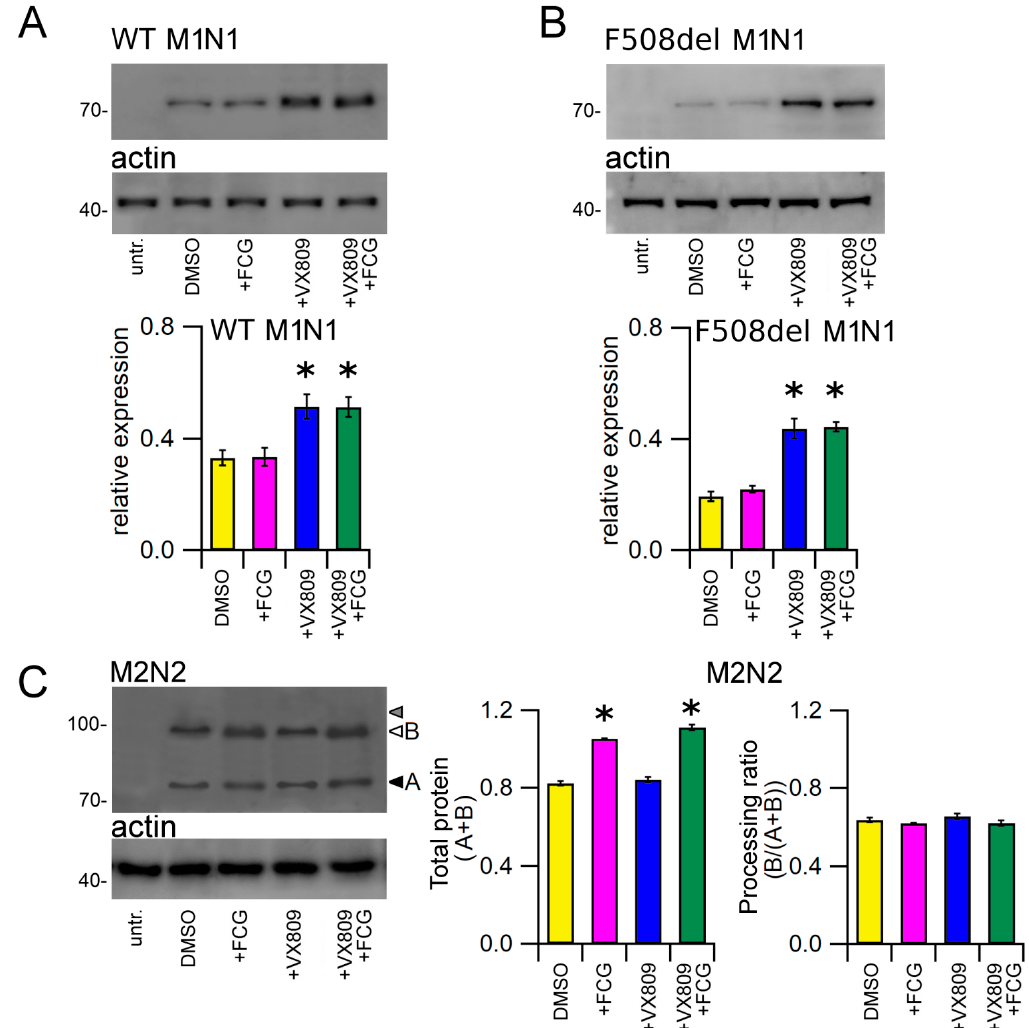
Figure 3. Effect of FCG, VX809, and FCG + VX809 on the expression of CFTR N- and C-halves. Western blots of WT ( A ), F508del M1N1 ( B ) and M2N2 ( C ) in untransfected and in transiently transfected in HEK-t cells treated with DMSO (control) or 10 µ M FCG, 5 µ M VX809, and 10 µ M FCG + 5 µ M VX809. White and black arrowheads in ( C ) indicate the position of bands B and A of the M2N2 polypeptide, while grey head arrow indicates the lack of band C, respectively. In the lower blots, the expression of actin, used as housekeeping protein, is shown. The molecular weight of the proteins of the molecular weight marker that was run in the SDS-PAGE is indicated on the left of each blot. The bar graphs on the bottom indicate the normalized expression level of CFTR N- and C-halves. Data are expressed as mean ± standard error of the mean (SEM) of at least four independent experiments. Dunnett’s test was used for data comparison. Asterisks indicate a statistical significance versus the control: * p <